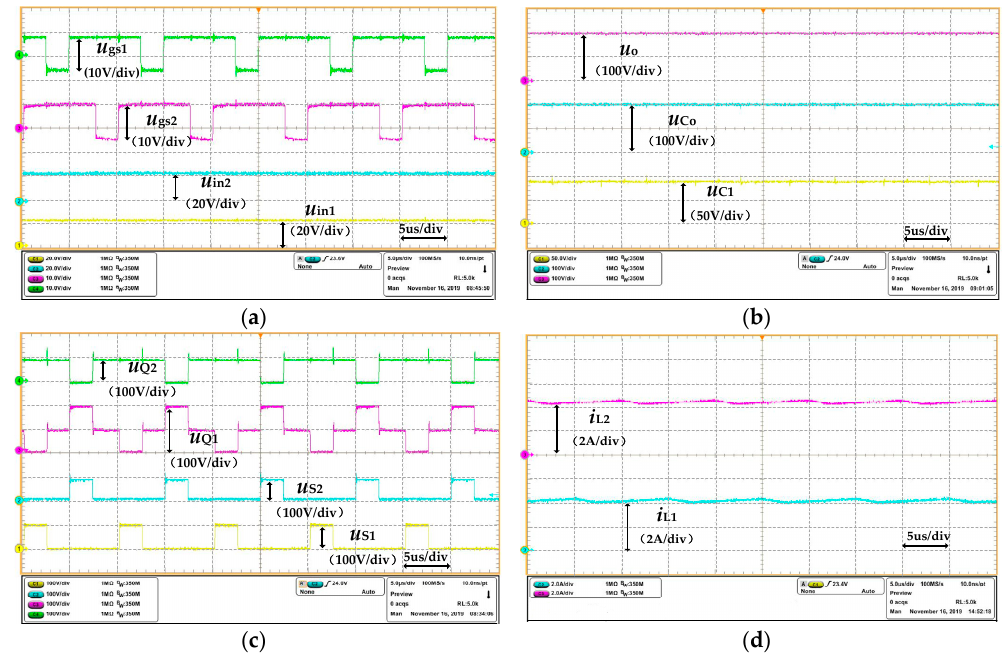
Figure 10. The waveforms of the experimental prototype. ( a ) driving waveforms of the switches and waveforms of the input voltage. ( b ) waveforms of voltages of C o , C 1 , and the waveform of the output voltage. ( c ) waveforms of voltages of the switches. ( d ) waveforms of currents of the inductors. Charging Mode (Buck): Figure 11a shows the waveforms of u gQ1 , u gQ2 , u in1 , and u in2 , the duty cycles are near 0.24. Figure 11b shows the waveforms of u o , u Co , and u C 1 ; it can be seen that the DC values of u C 1 , u o are about 100 V, 200 V, and the conversion gain is approximately 0.12, which is consistent with Equation (10). Figure 11c shows voltage stresses of S 1 , S 2 , Q 2 are nearly 100 V, and the voltage stress of Q 1 is about 200 V, which are consistent with Equations (18) – (20). Figure 11d shows the waveforms of i L 1 , i L 2 . The DC values of i L 1 , i L 2 are both about 4 A; evidently, the measured results are all consistent with the theoretical analysis.